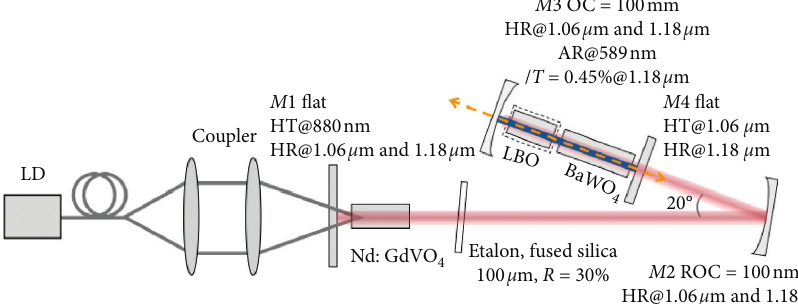
Figure 18: Schematic of the single-frequency intracavity Raman laser [72].